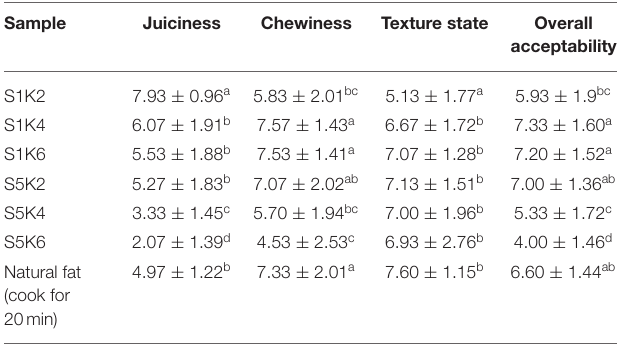
TABLE 2 | Sensory score results of the fat substitutes with different protein and konjac content levels and natural meat fat. Sample Juiciness